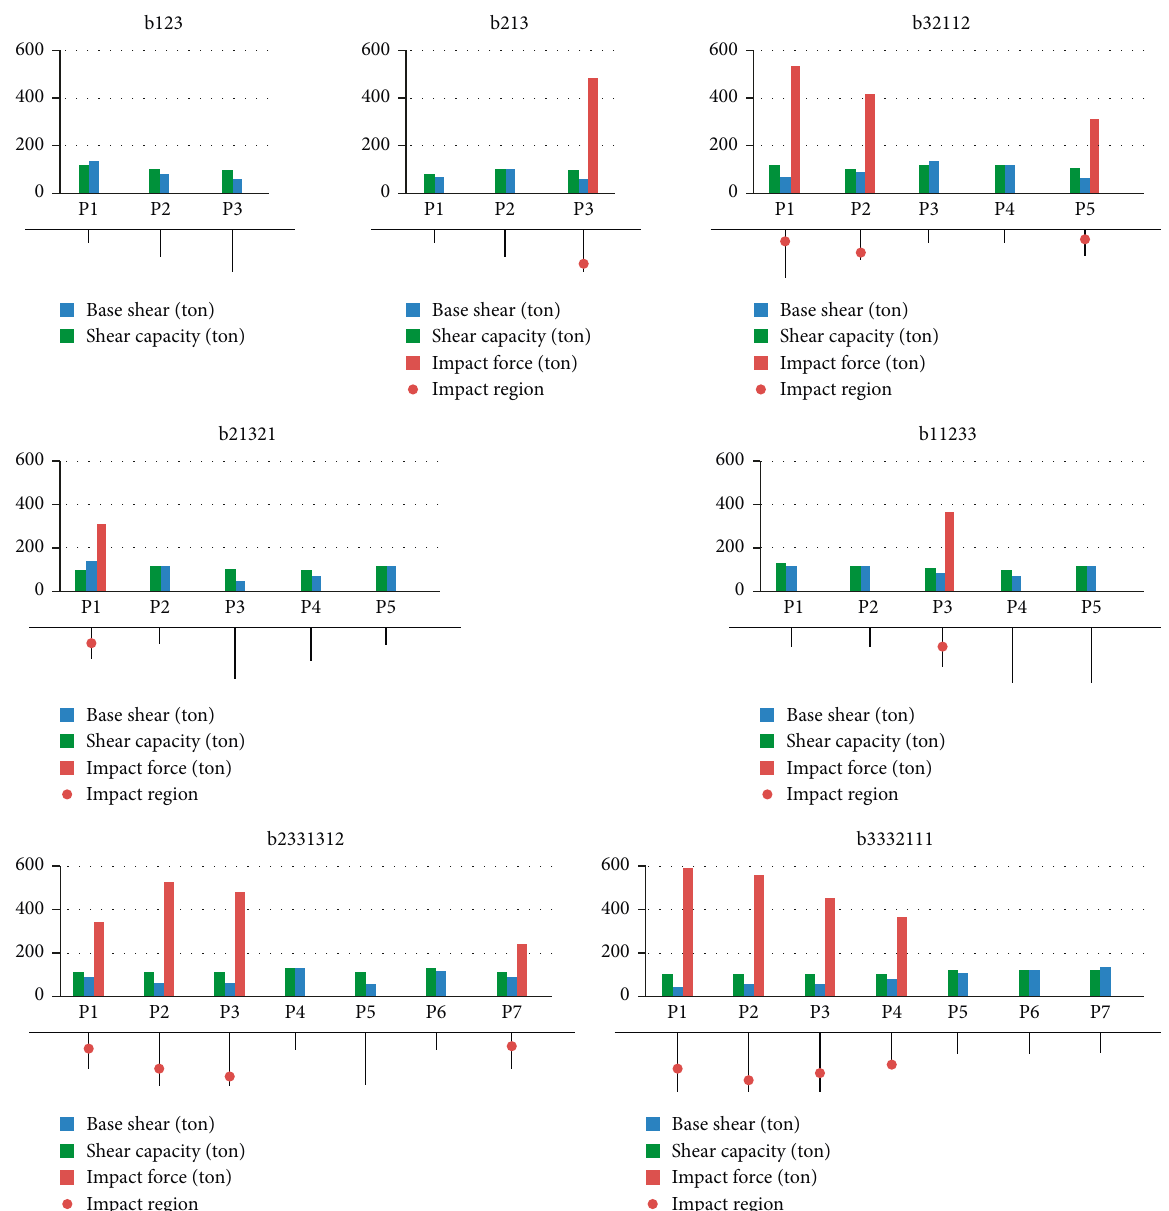
Figure 20: General information and overall view of comparing impact force with seismic base shear forces and the collision region in semiregular and irregular bridges under the artificial ground